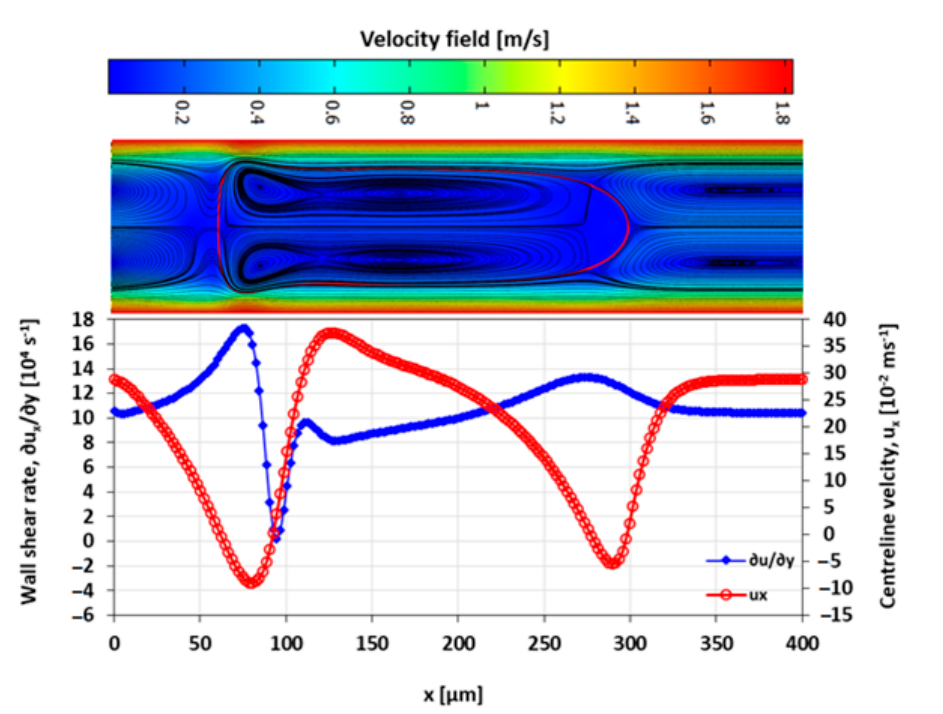
Figure 17. Wall shear rate and the x-velocity at centreline ( 𝑦 = ℎ/2 ) for 𝜆 = 2 and 𝐶𝑎 = 0.21 .